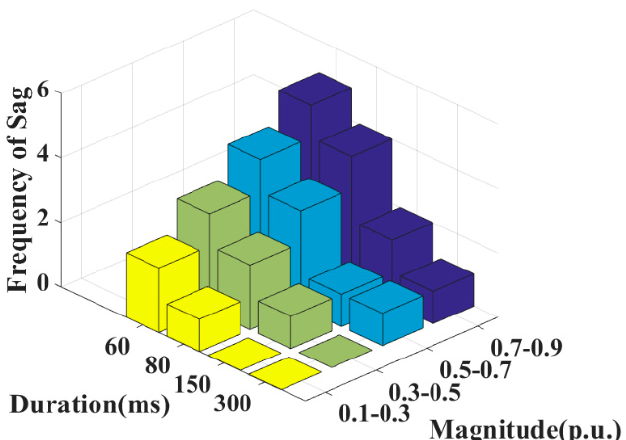
Figure 13. Sags per year for magnitude ranges and duration for bus 10. Table 4. Frequency of sag with respect to duration and magnitude ranges for bus 10 . Magnitude Ranges (p.u.) Duration in Milliseconds (ms) 60 ms